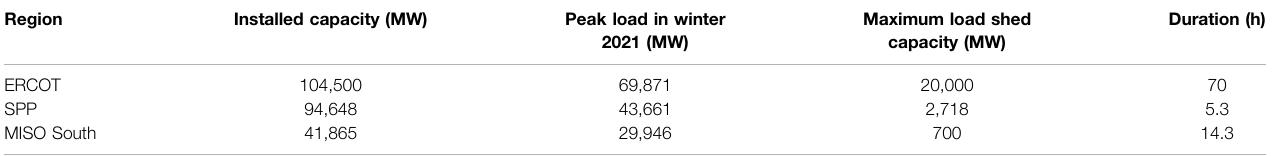
TABLE 1 | Comparison of the affected ISO/RTOs in the 2021 Texas power crisis.